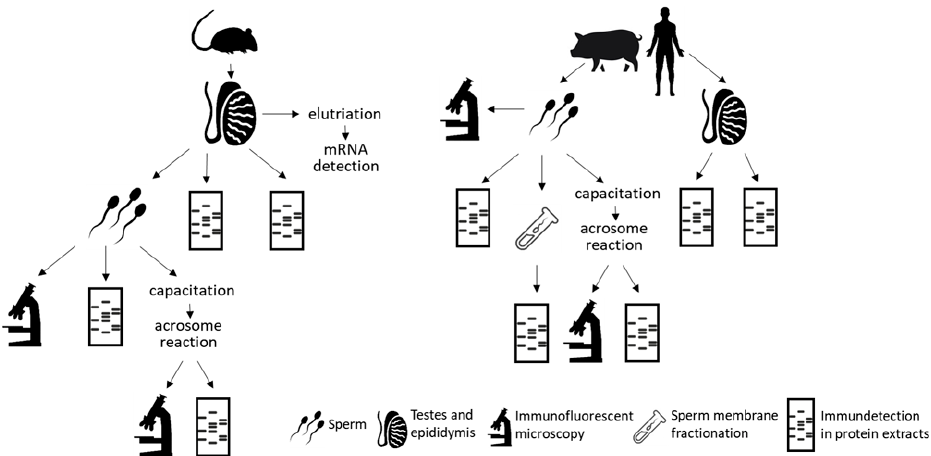
Figure 1. Scheme describing design of experimental study and use of selected methods.